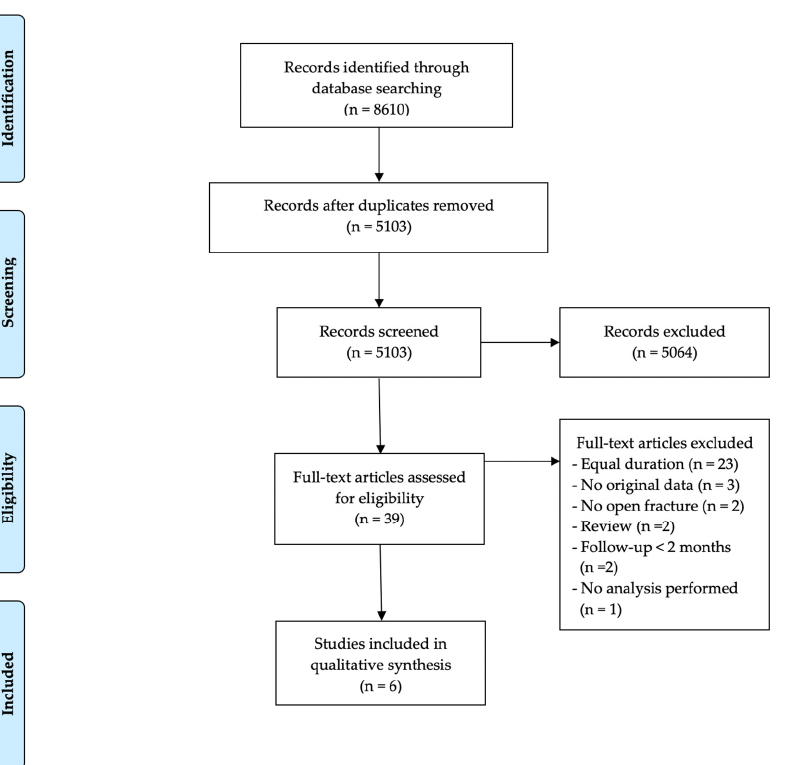
Figure 1. Outline of the search and selection process including exclusions and final number of studies included.